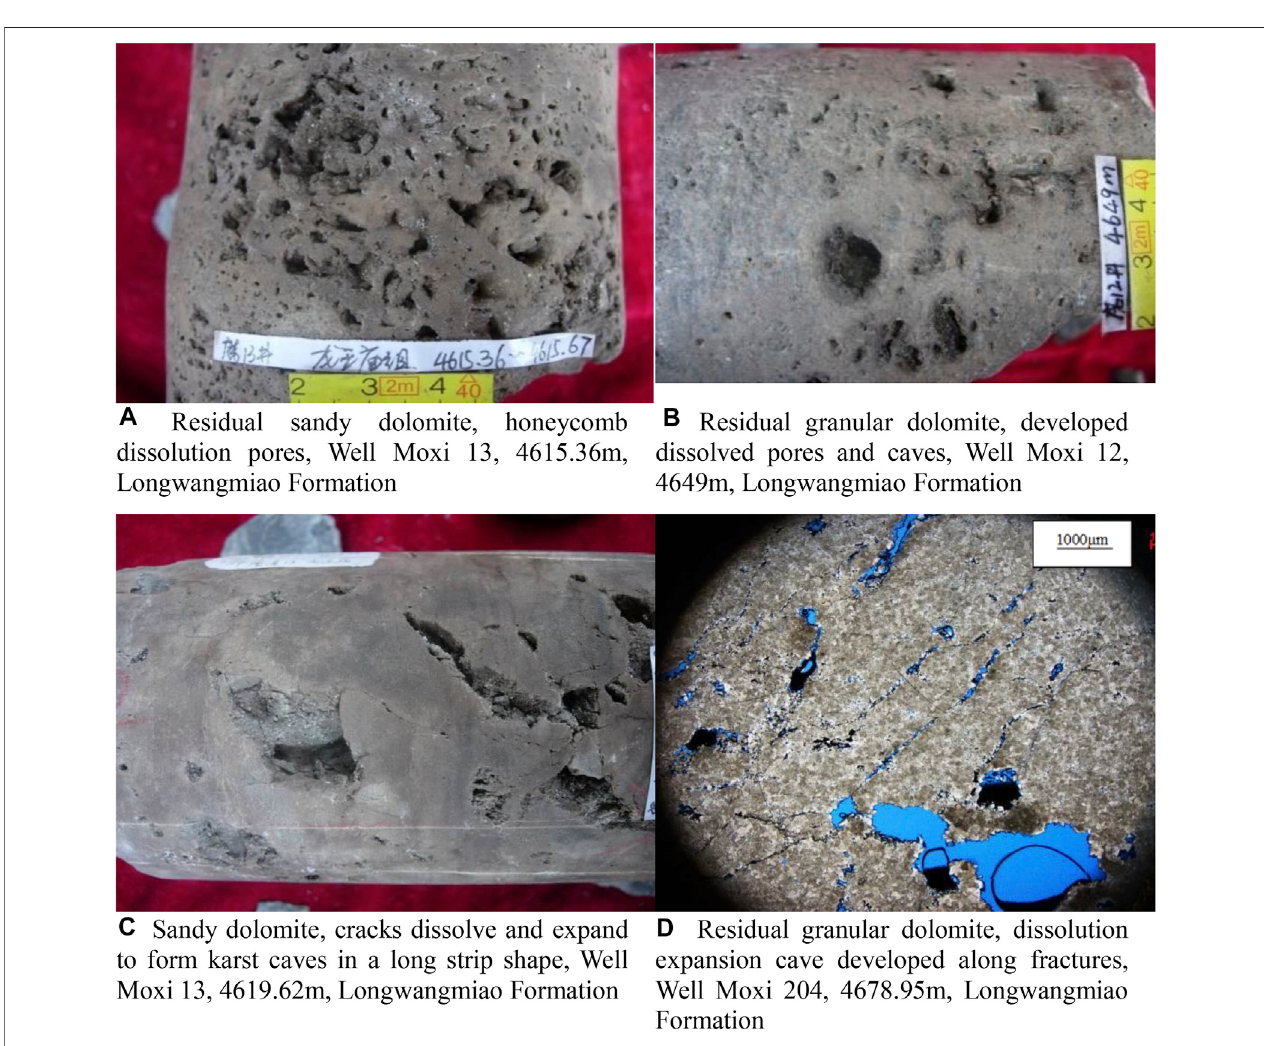
FIGURE 7 | Characteristics of pores and hole in Cambrian reservoirs in the Sichuan Basin (II). (A) . Residual sandy dolomite, honeycomb dissolution pores, Well Moxi 13, 4,615.36 m, Longwangmiao Formatio, (B) . Residual granular dolomite, developed dissolved pores and caves, Well Moxi 12, 4,649 m, Longwangmiao Formation, (C) . Sandy dolomite, cracks dissolve and expand to form karst caves in a long strip shape, Well Moxi 13, 4,619.62 m, Longwangmiao Formation, (D) . Residual granular dolomite, dissolution expansion cave developed along fractures, Well Moxi 204, 4,678.95 m, Longwangmiao Formation.